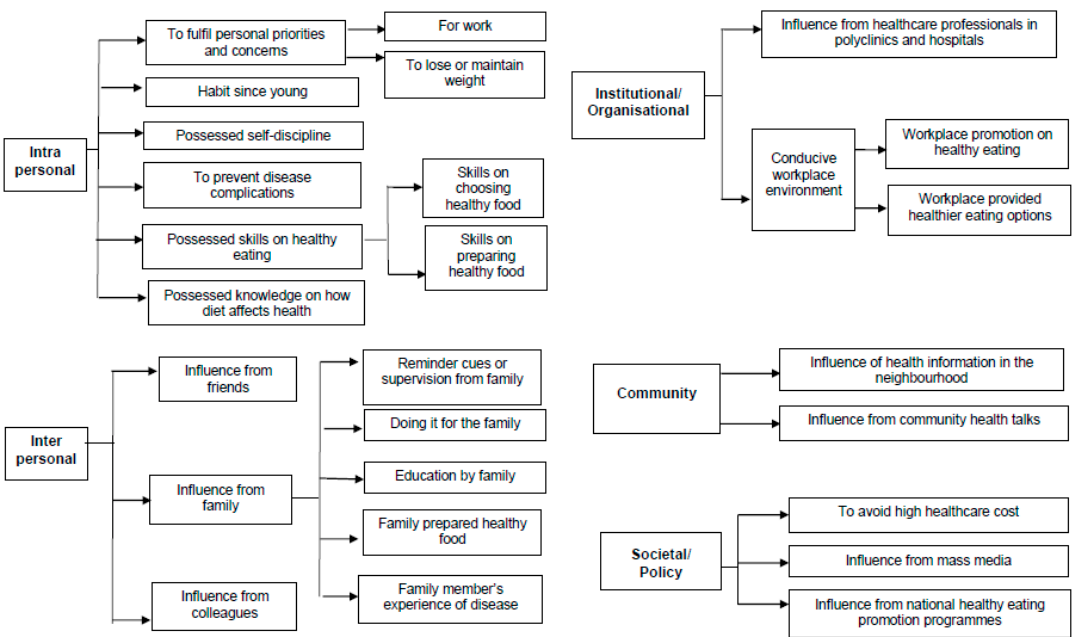
Figure 1. Themes and subthemes pertaining to reasons for meeting My Healthy Plate recommendation.